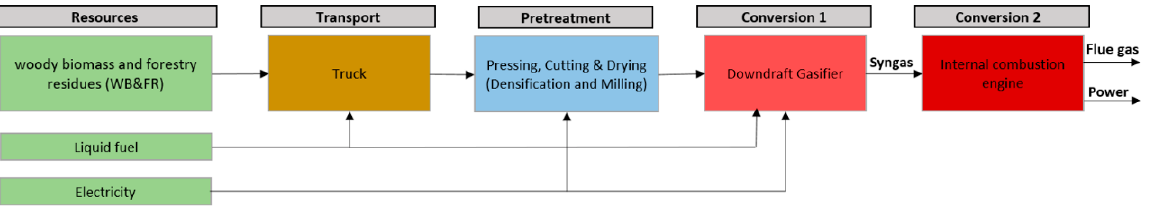
Figure 1. System boundaries, technologies, and associated inputs.